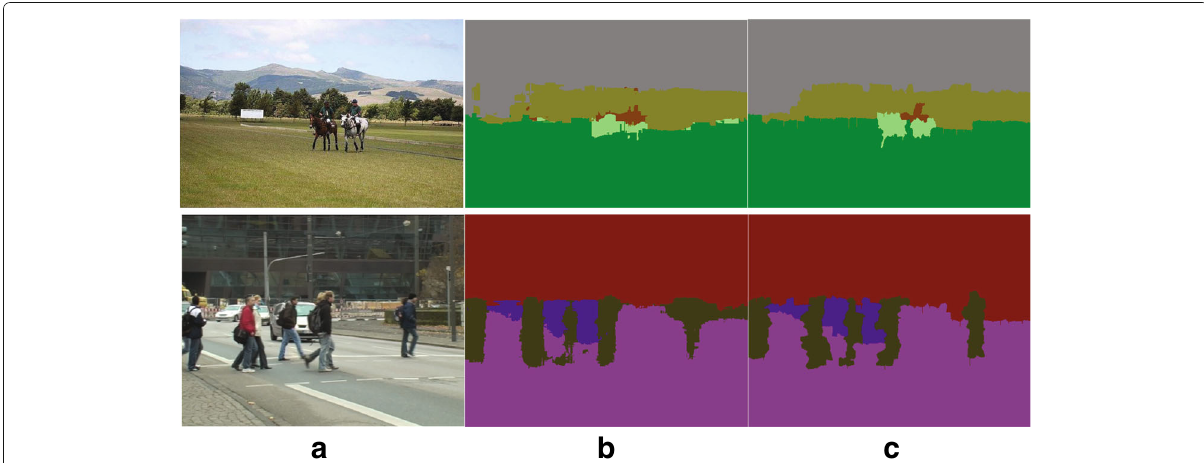
a b c Fig. 8 Comparison of raw labeling and final labeling of our method. a The image. b , c The raw and final labeling respectively. Our method improves the boundaries of objects Baseline methods. We adopt several baseline methods for quantitative comparison. For scene-level labeling com- parison, the baseline is referred to that of Shotton et al.